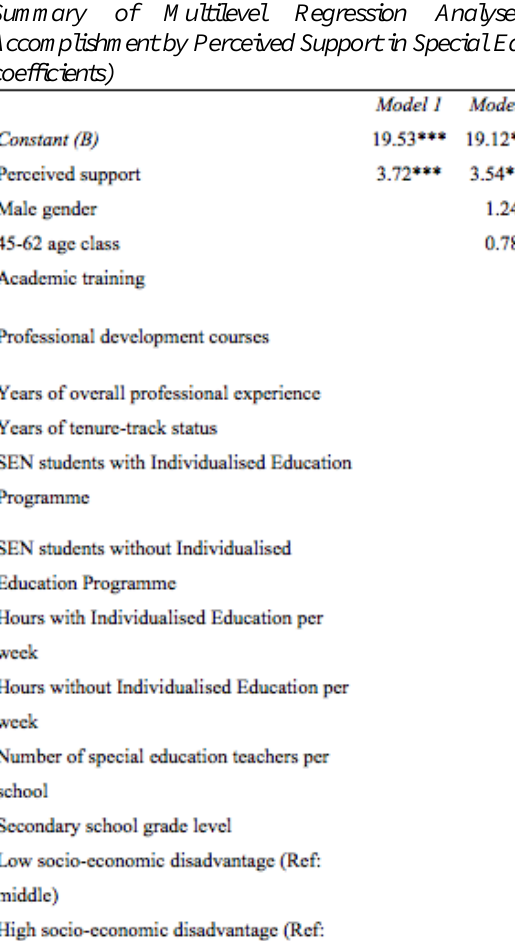
characteristics (Model 2), teachers’ training and professional background (Model 3), inclusive teaching practice (Model 4) and school-related variables (Model 5).